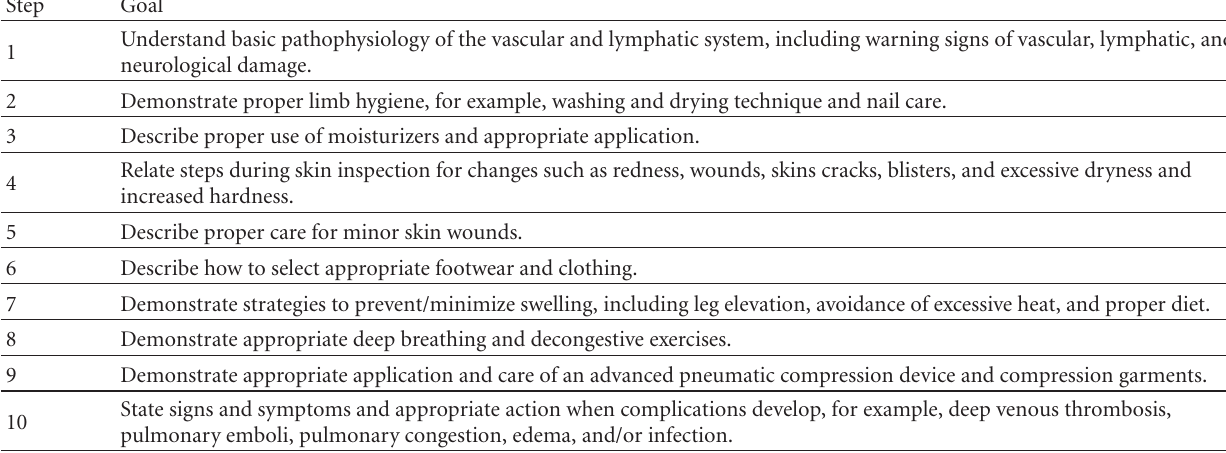
Table 1: 10 Steps to healthier feet and